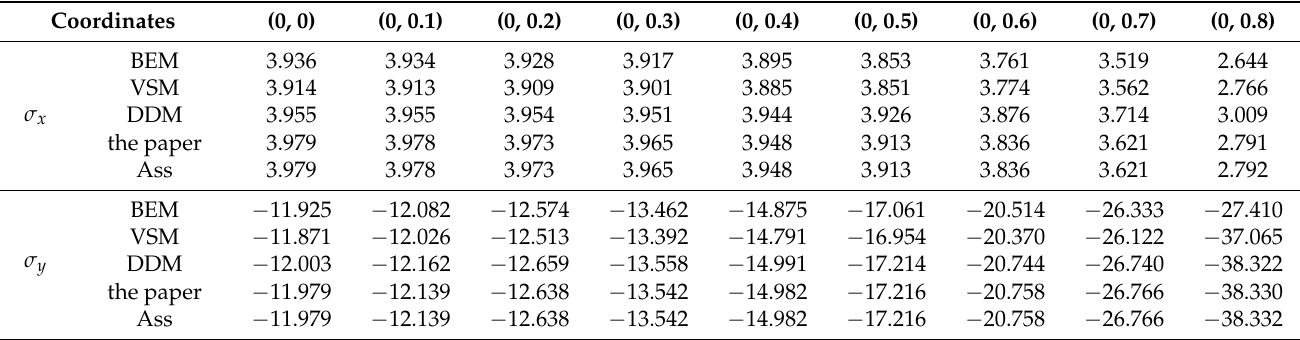
Table 1. The stresses σ x (MPa) and σ y (MPa) at points ( x = 0 and y dm) of the axial compression on the part boundary of the circular shaft.